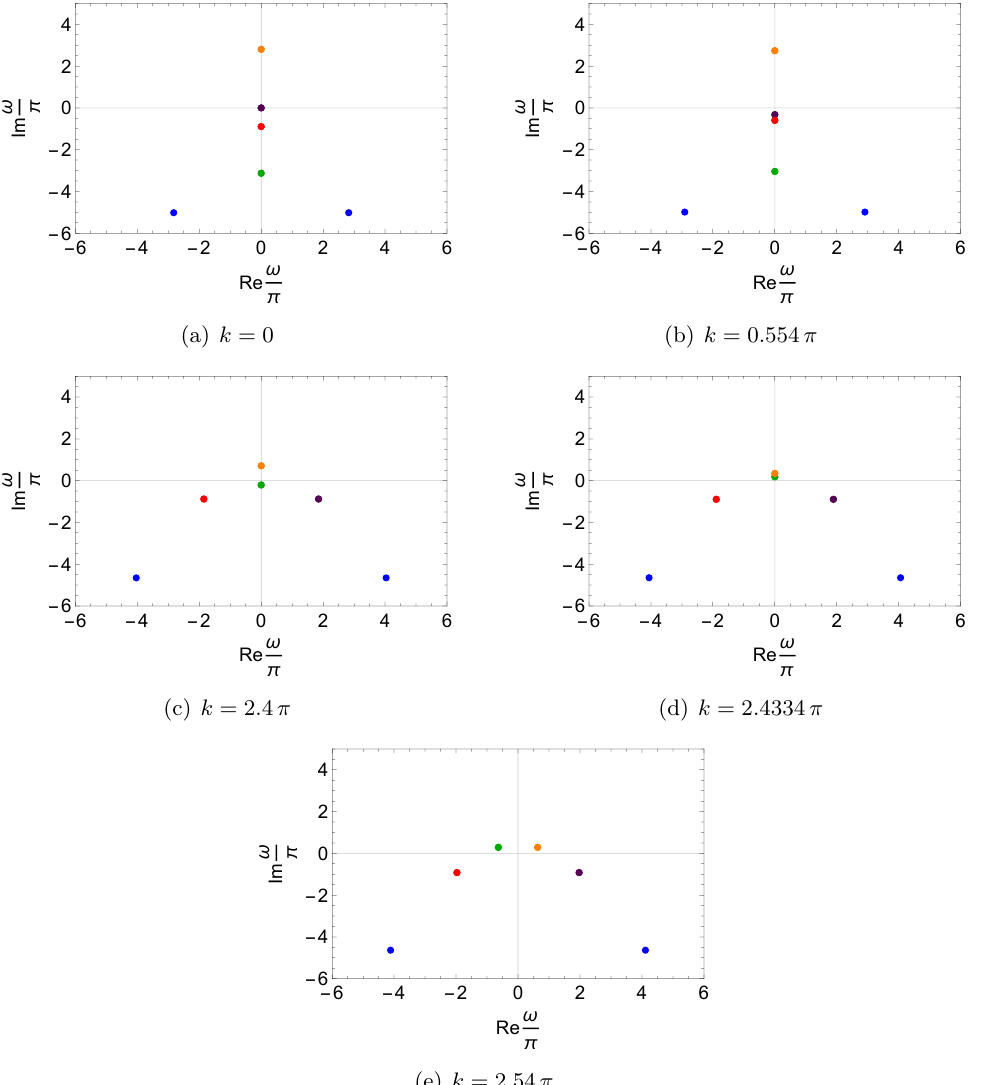
Figure 3 . Behavior of the first six QNMs in complex frequency plane with varying k at ˆ β = 0 . 35 . As k evolves, the diffusion pole ω D shown in purple (and is at the origin at k = 0 ) collides with the quasi-hydro mode ω Q shown in red on the negative imaginary axis, and subsequently both of them transform to a pair of quasinormal modes with almost k -independent negative imaginary parts. The other mode ω G shown in green moves upwards on the imaginary axis, crosses the origin and collides with the downward moving ω U shown in orange above the origin. Subsequently both of them transform into a pair of unstable quasi-normal modes with almost k -independent positive imaginary